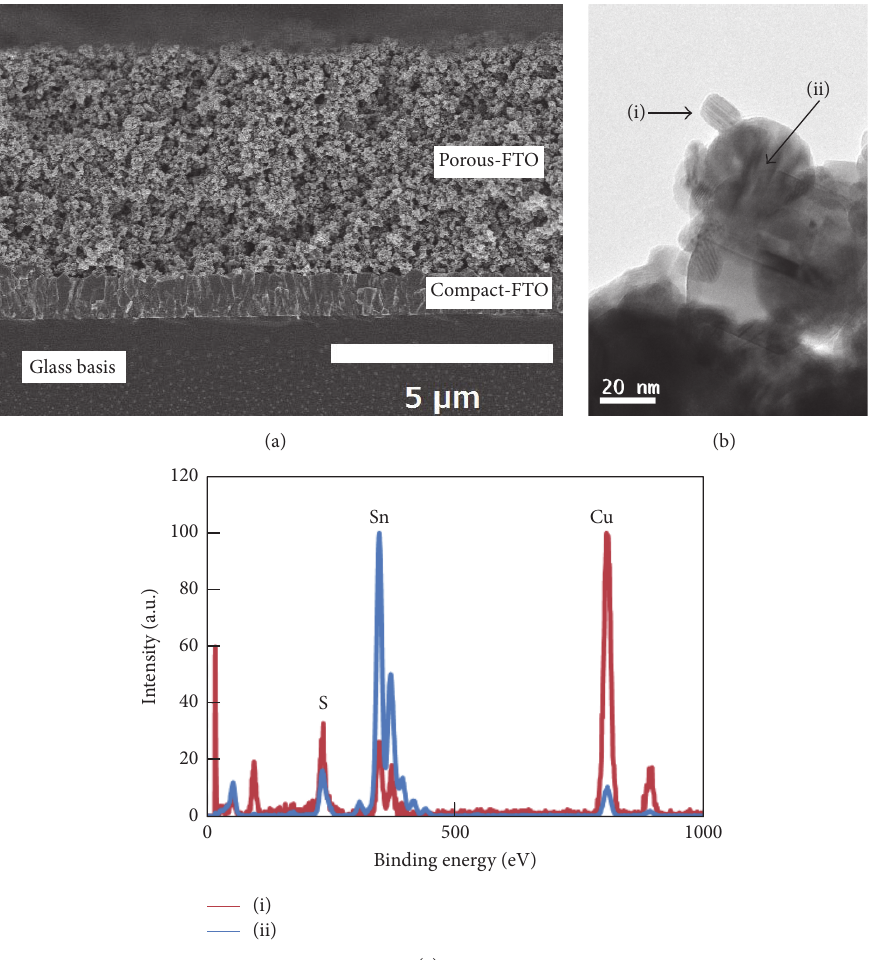
Figure 3: Cross-sectional SEM image of a porous-FTO electrode (a), TEM image of the porous-FTO (ii)/CuS (i) composite removed from the counter electrode surface (b), and EDX point analysis at points (i) and (ii) in the TEM image